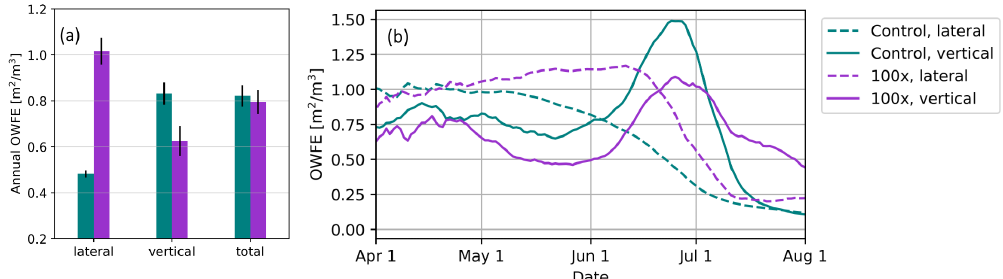
Figure 13. Open-water-formation efficiency (OWFE) in the Northern Hemisphere for 2 × CO 2 forcing runs. (a) Annual average OWFE for lateral melt, vertical melt processes, and total melt. Colored bars show the 25-year mean, with control run in teal, 10 × lateral melt run in blue, 100 × lateral melt run in purple, and redistributed lateral melt in light red. Black bars denote 1 standard deviation. (b) Daily OWFE throughout the Arctic melt season of lateral melt (dashed lines) and vertical melt (solid lines) for control and 100 × lateral melt runs (teal and purple,